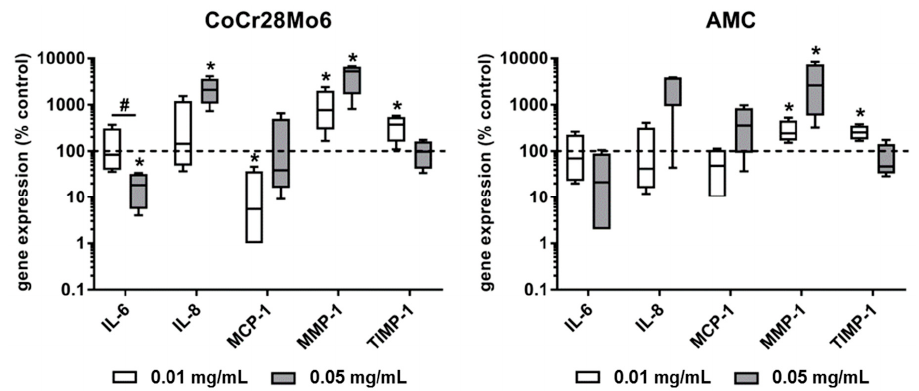
Figure 3. Gene expression analyses of pro-osteolytic markers in human primary fibroblasts following exposure to CoCr28Mo6 and AMC particles. Cells were cultivated in standard cell culture plates. After 24 h of adherence cells were exposed to particles over a period of 96 h. Afterwards, total RNA was isolated and reverse transcribed. Gene expression analyses were performed by qRT-PCR. Data are presented as box plots ( n = 4; all data are in relation to unstimulated cells (%)). Significance was calculated using the Mann-Whitney- U -test (* p < 0.05, stimulated vs. unstimulated; # p < 0.05, 0.01 mg/mL vs. 0.05 mg/mL).